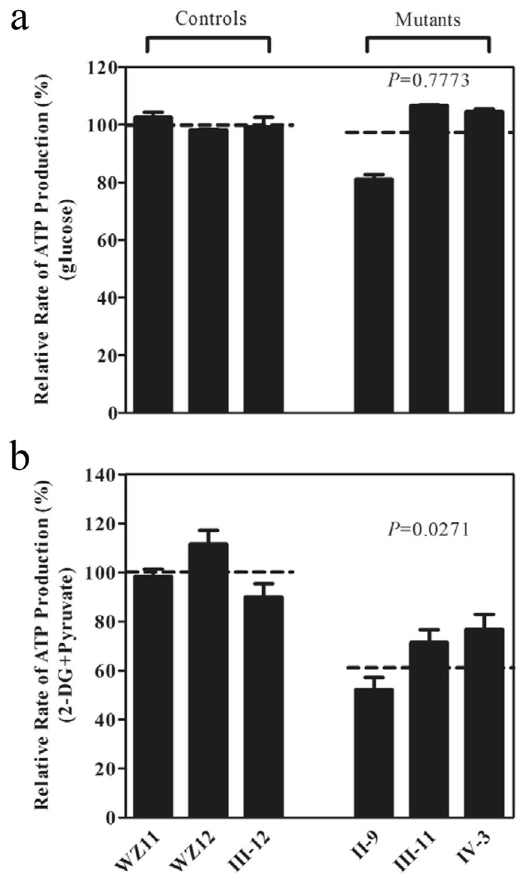
Figure 5. Measurement of cellular and mitochondrial ATP levels using bioluminescence assay. Cells were incubated with 10 mM glucose or 5 mM 2-deoxy-D-glucose plus 5 mM pyruvate to determine ATP generation under cellular and mitochondrial ATP levels. Average rates of ATP level per cell line are shown: ( a ) ATP level in total cells and ( b ) ATP level in mitochondria. Six to seven determinations were made for each cell line. Graph details and symbols are explained in the legend to Fig.